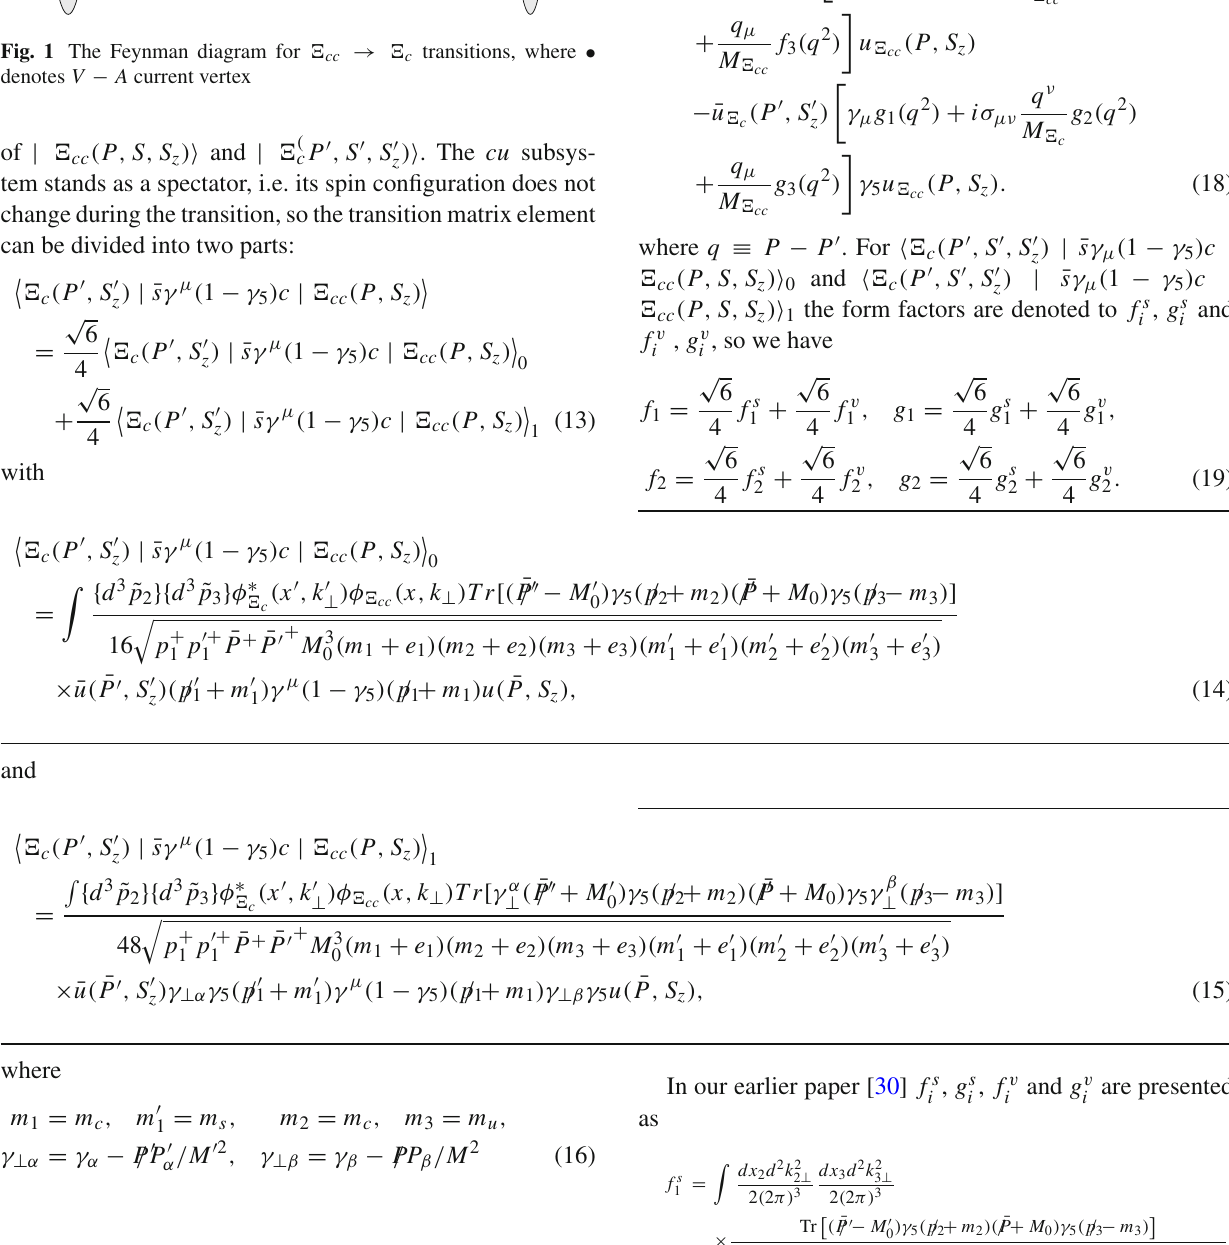
( (cid:3) , S (cid:3) , S (cid:3) ) (cid:4) . The cu subsys- c P z